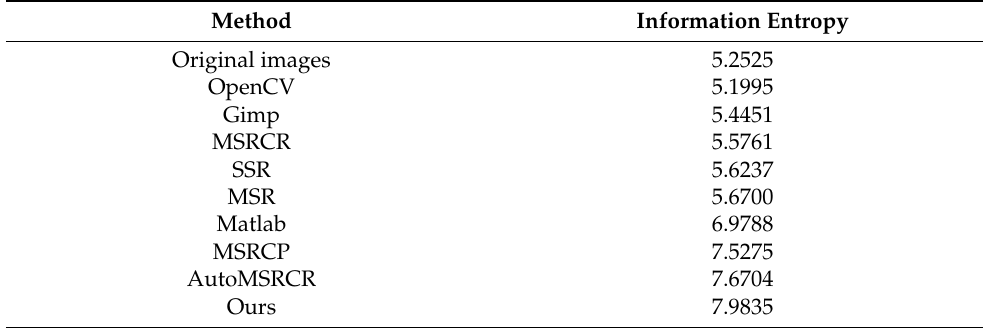
Table 1. Information entropy of crack defect images processed by various algorithms.